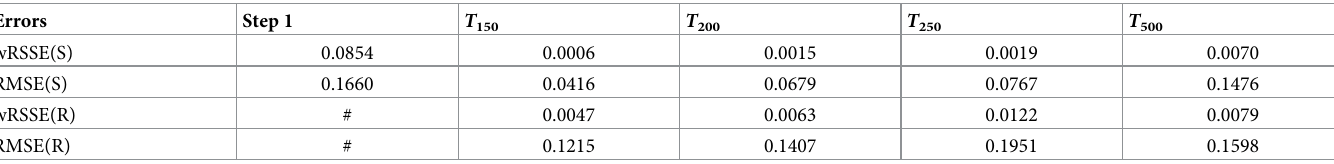
Table 2. Error indexes of 9 kinetic parameters in modeling unbuffered gene network. The wRSSE and RMSE indexes are selected to evaluate the performance of param- eter estimation. The column denoted Step 1 represents the single and double inputs with the same concentration 20 μM . The columns T 150 , T 200 , T 250 and T 500 denote the periods of square inputs are 150, 200, 250 and 500mins. The symbol # indicates the shortage of relevant